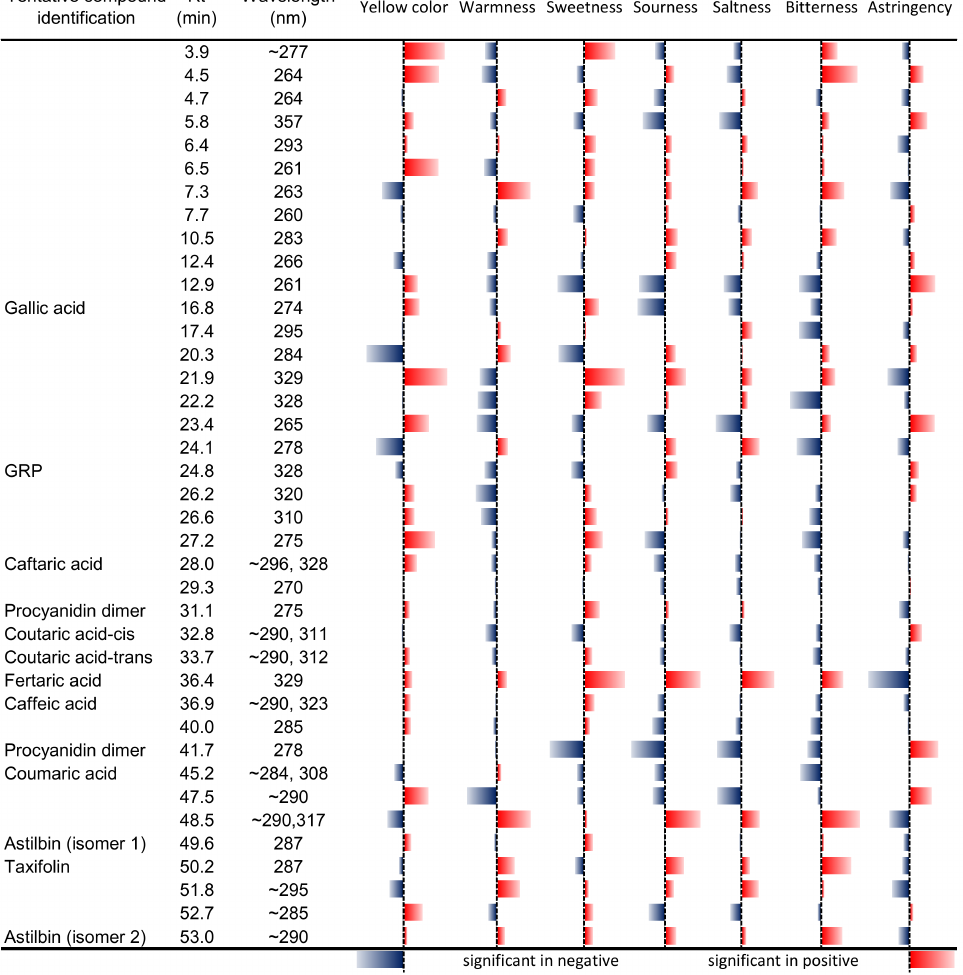
Figure 5. Summary of the calculated p -values and standardized coefficients of the phenolic com- pounds in the regression models. The absolute length of the bars represents the significance expressed as “1/ p -value”; consequently, the longer the bar is, the more significant is the effect of that compound. The colour and the direction of the bar indicate instead the sign of the standardized coefficient in the respective regression equation: Red = positive sign/correlation, blue = negative